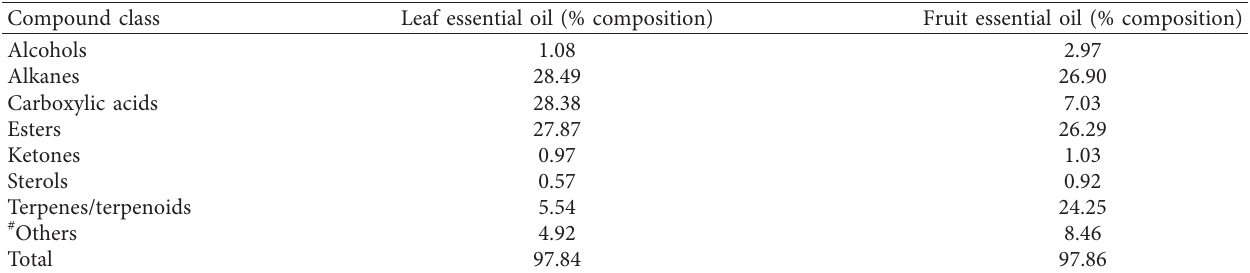
Table 3: Classification of compounds identified in both leaf and fruit essential oils of Chrysophyllum albidum . Compound